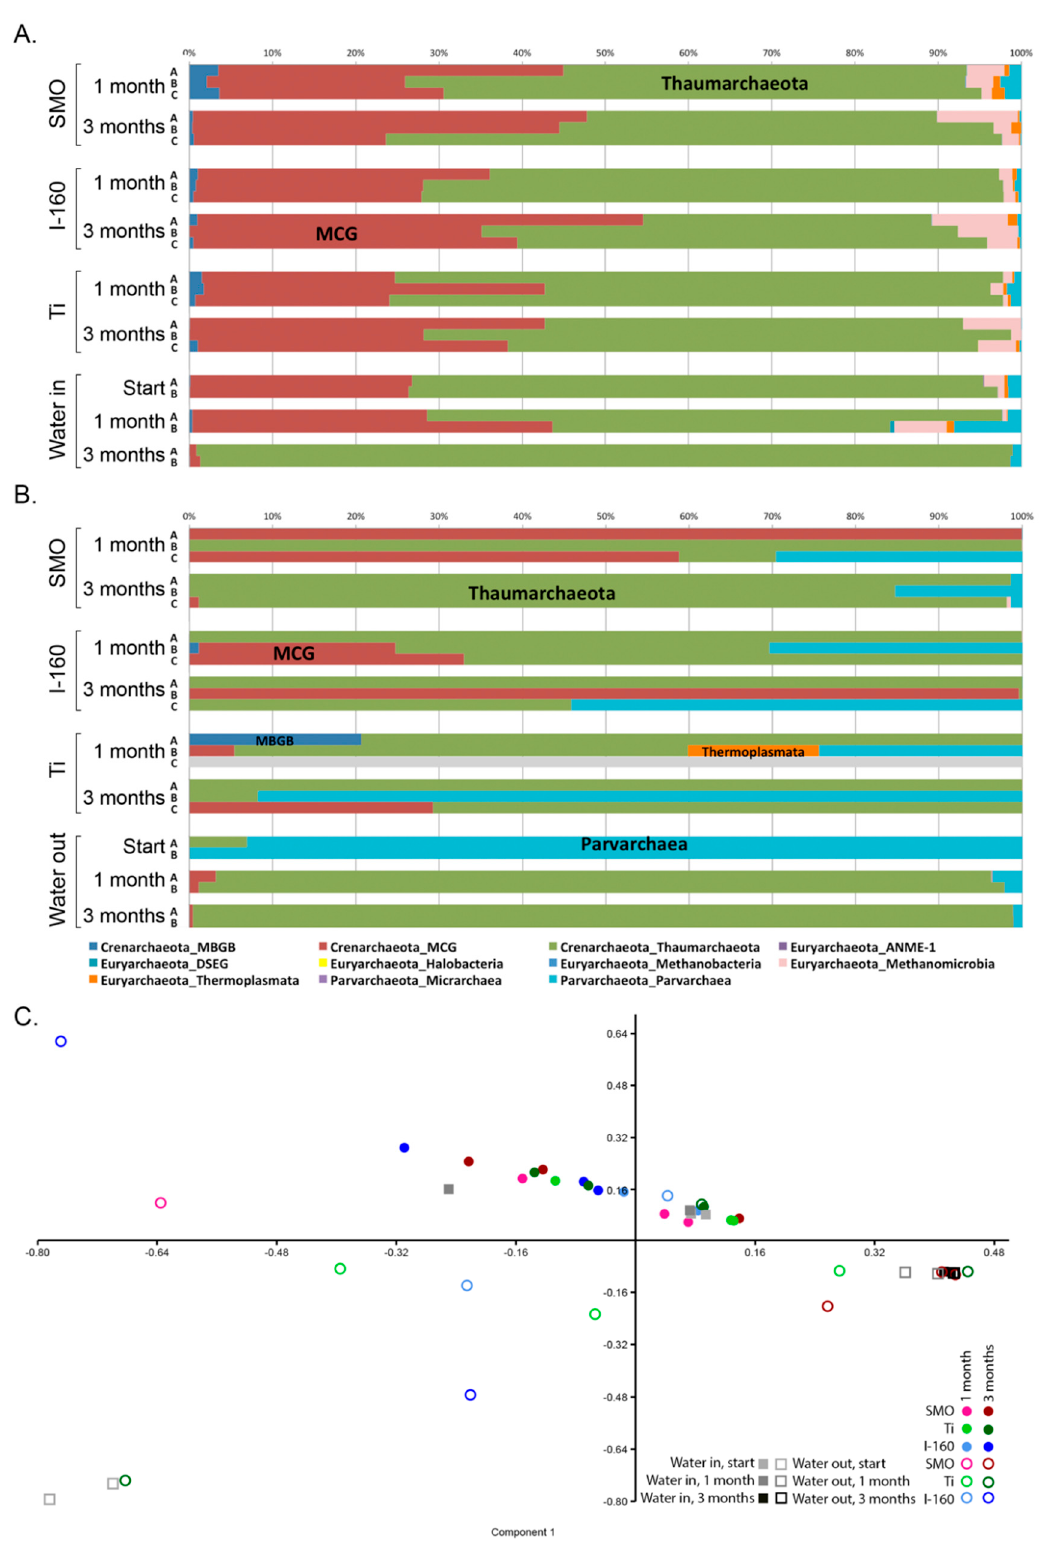
Figure 7. The archaeal community composition of ( A ) the non-chlorinated and ( B ) chlorinated samples; ( C ) a PCA plot based on the archaeal community (family level). In ( C ), open symbols indicate chlorinated and solid symbols non-chlorinated samples. Component 1 explains 67.8% and Component 2 explains 35.1% of the variance, with Thaumarchaeota, the Miscellaneous Crenarchaeotal Group (MCG) and Parvarchaea dominating the axis loadings.